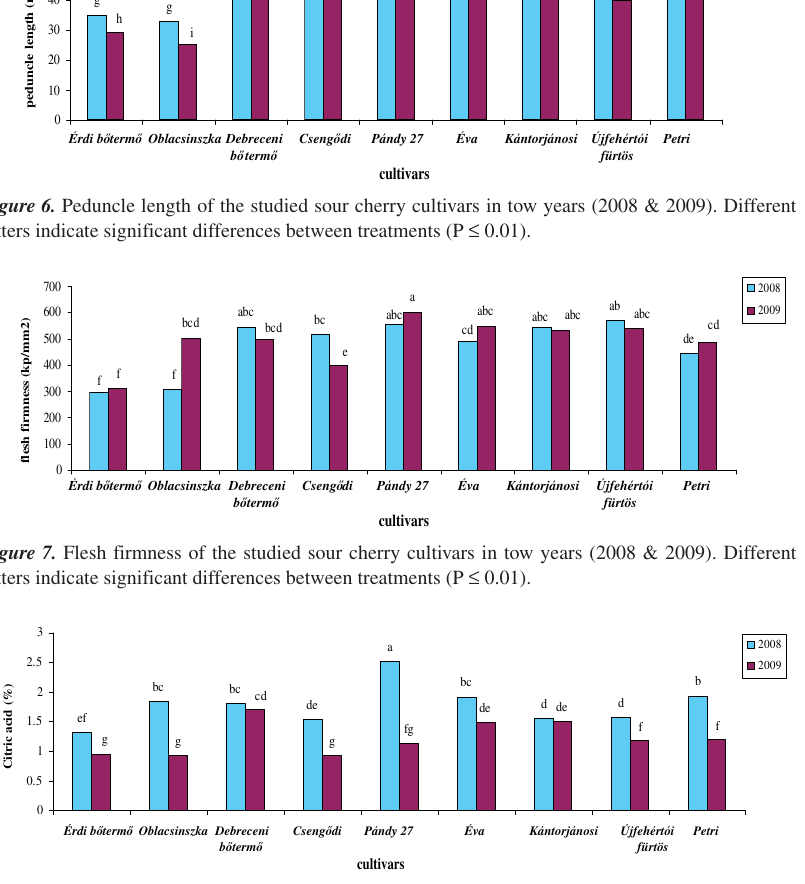
Figure 8. Citric acid of the studied sour cherry cultivars in tow years (2008 & 2009). Different letters indicate significant differences between treatments (P ≤